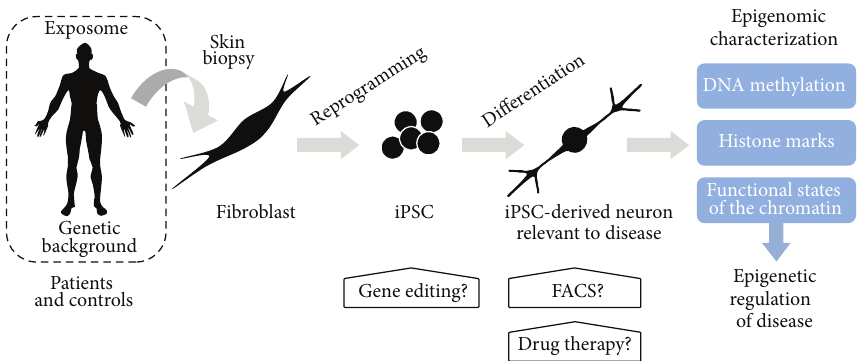
Figure 1: Possible experimental design of epigenomic characterization of neurodegenerative diseases using patient-specific iPSC-derived neural